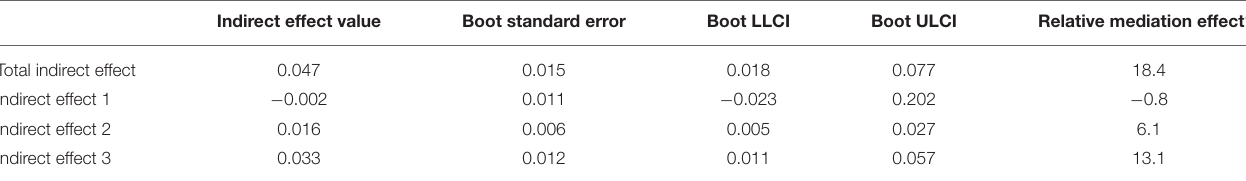
TABLE 3 | Test of mediation